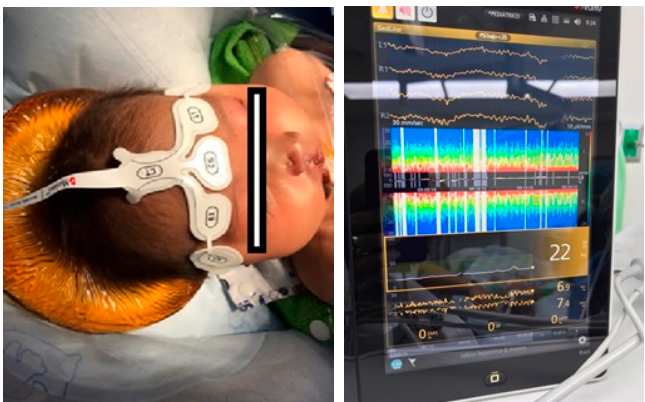
Figure 2. A 6-month-old patient. The EEG shows a spectrogram with very low potency in the alfa band despite low concentrations of propofol (1.6 ug/ml).